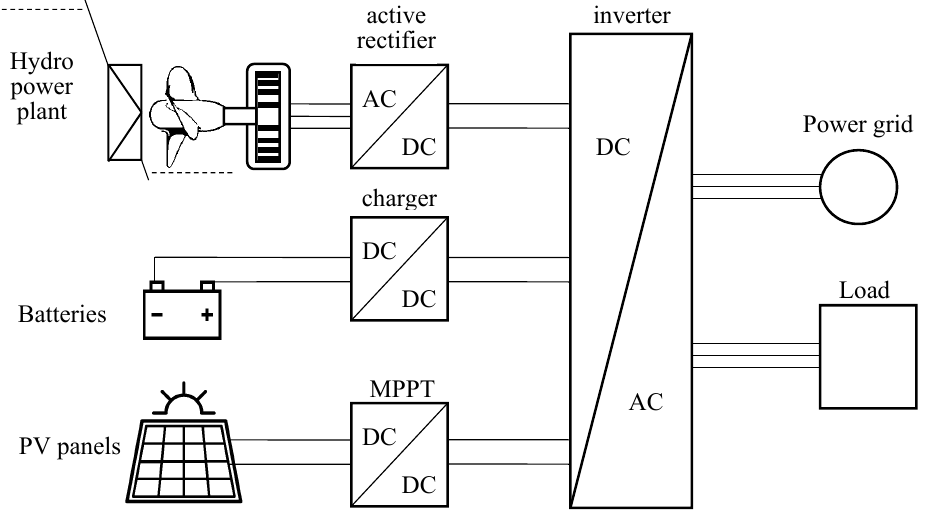
Figure 1. Schematic of the hybrid run-of-the-river hydropower plant/PV/batteries system.